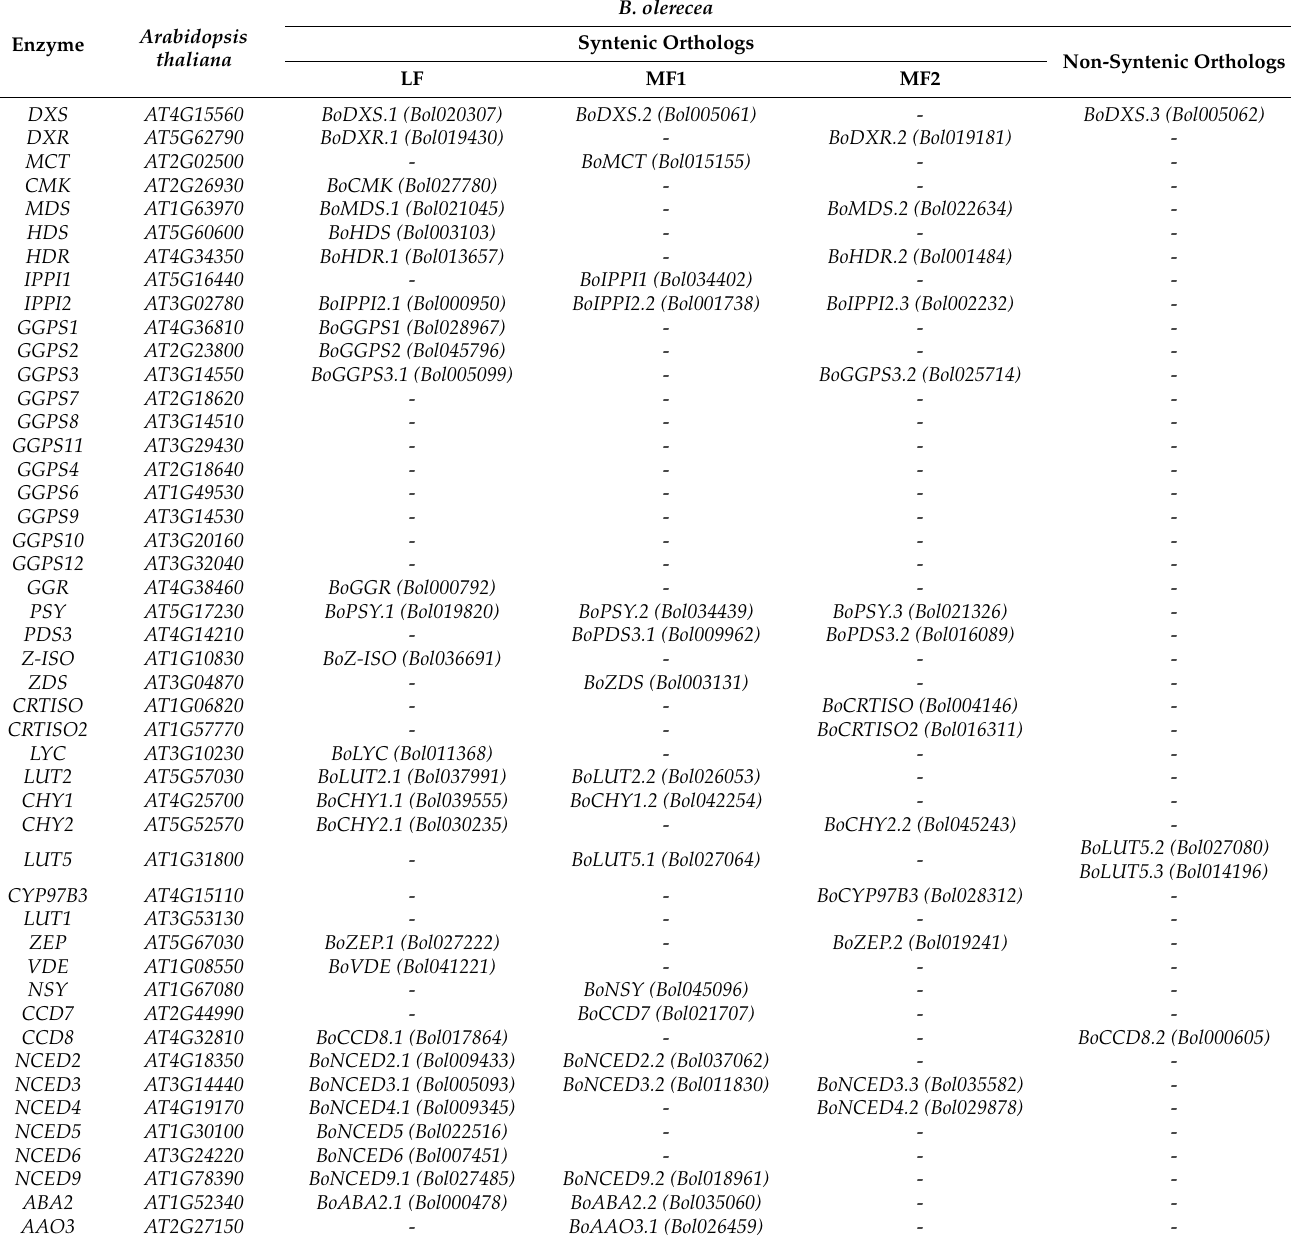
Table 1. Carotenoid biosynthetic genes identified in